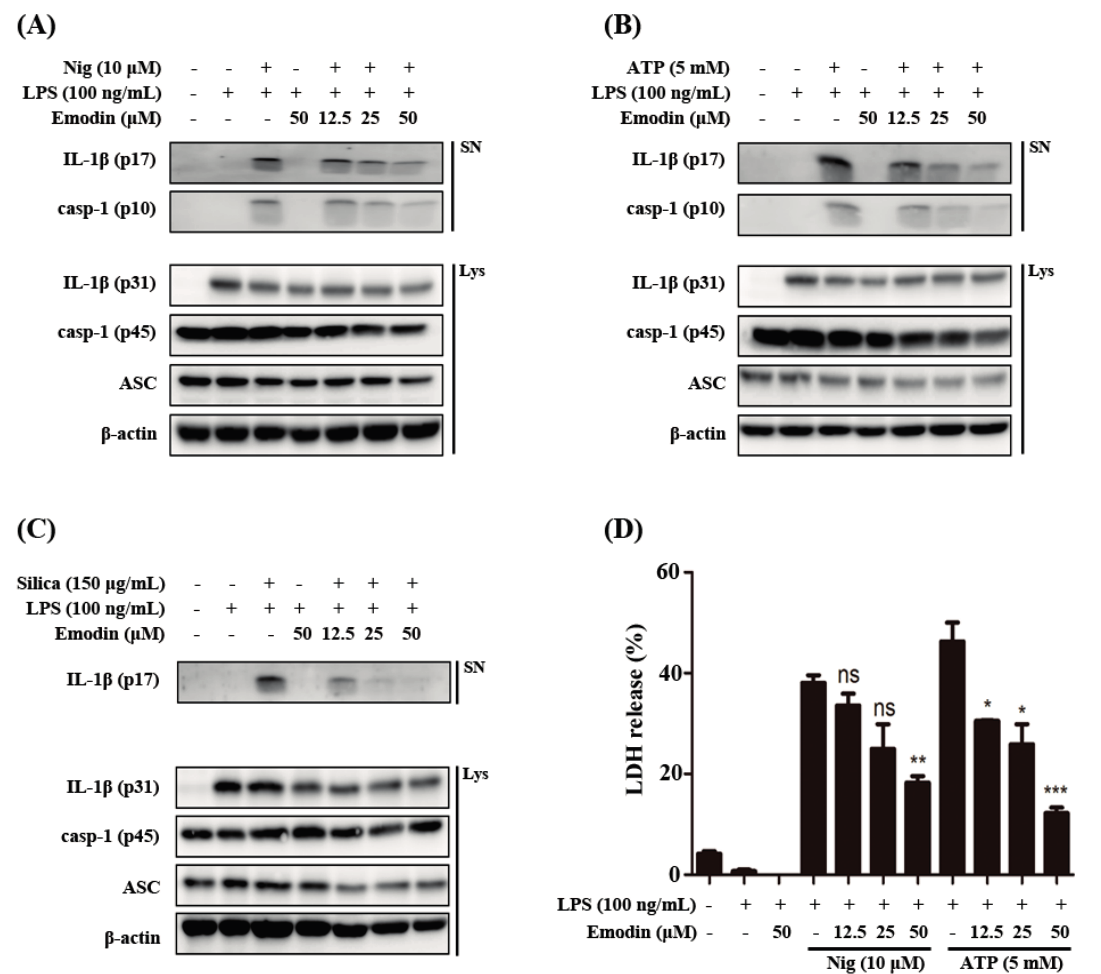
Figure 1. Effects of emodin on inflammasome-induced interleukin (IL)-1 β secretion and cell death in vitro. LPS-primed bone marrow-derived macrophages (BMDMs) were pretreated with emodin for 1 h and stimulated with ( A ) nigericin (Nig) (10 μ M) and ( B ) ATP (5 mM) for 1 h, and ( C ) silica crystals (silica) (150 μ g/mL) for 3 h, and supernatants (SN) were used to detect cleaved IL-1 β (p17) and caspase-1 (p10). Cell lysates (Lys) were used to detect internal controls, such as pro-IL-1 β (p31), ASC, pro-caspase-1 (p45), and β -actin; ( D ) LPS-primed BMDMs were treated with emodin at the indicated concentration for 1 h and then treated with nigericin (Nig) (10 μ M) and ATP (5 mM) for 1 h, after which supernatants were collected for LDH determination. The results are expressed as mean ± S.E.M. of three independent experiments in triplicate. * p < 0.05, ** p < 0.01 and *** p < 0.001 compared with Nig, ATP treated cells. ns: None